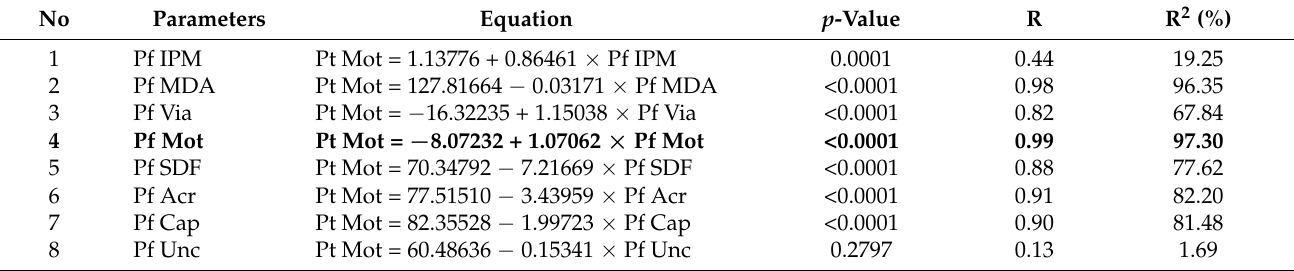
Table 4. Regression equation of post-thawed motility (Pt Mot) based on pre-freezing semen quality